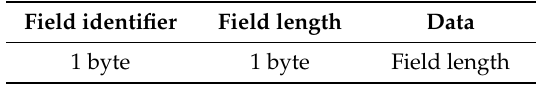
Table 6. Traffic capture interface protocol. Payload Optional fields